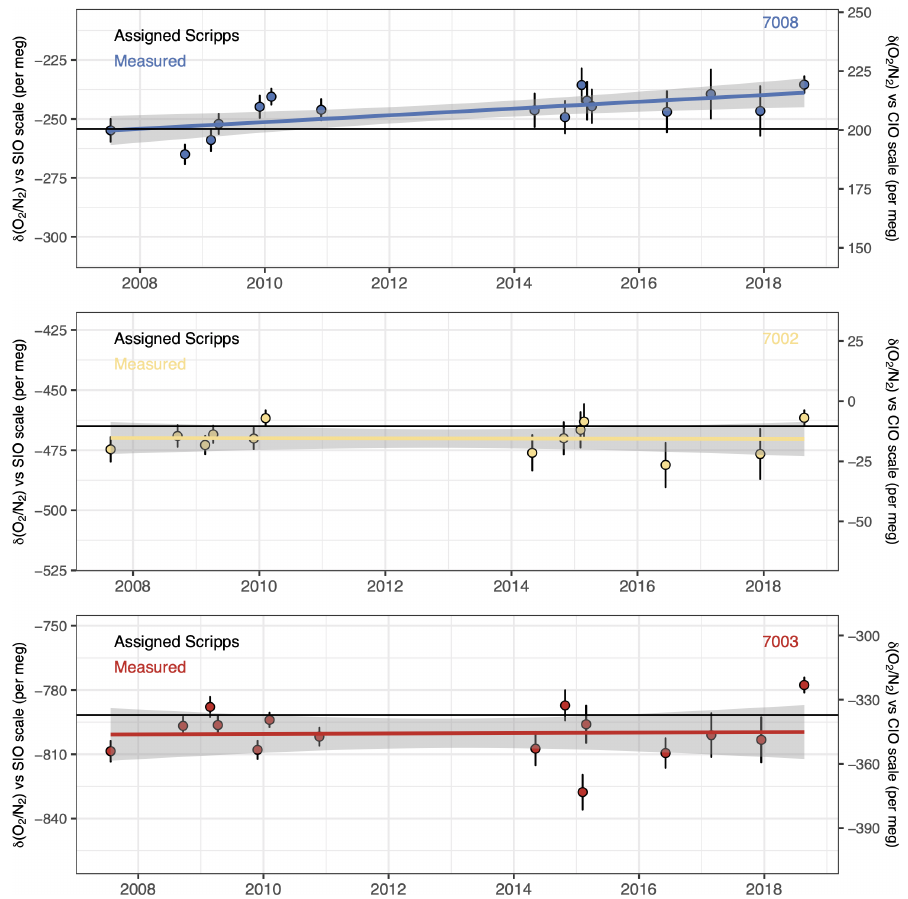
Figure 5. Scripps primary standard cylinder measurements over time. Each point is the averaged value over a measurement period. Error bars represent 1 σ standard deviations. Solid horizontal lines are the assigned values (black) and the linear least squares fit to the data (coloured) of each cylinder. The grey shading indicates the 95% confidence interval uncertainties of the